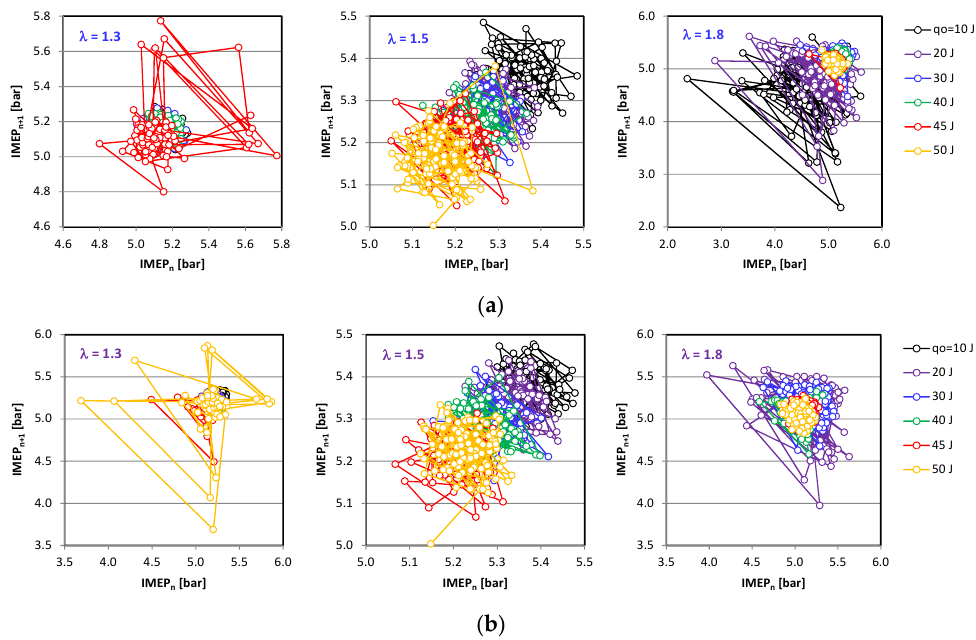
Figure 8. Unevenness of engine cycles determined by IMEP maps for each value of excess air ratio and di ff erent values of fuel dose energy injected into the prechamber: ( a ) when burning propane in the prechamber; ( b ) when burning methane in both chambers. The analysis of inter ‐ chamber tides is shown in Figure 9. The pressure di ff erence between chambers was chosen as the parameter representing mass transfer intensity. The combustion of fuels at λ = 1.3 (Figure 9a) shows the smallest pressure di ff erence between volumes when various fuels are combusted. A higher value was recorded during the